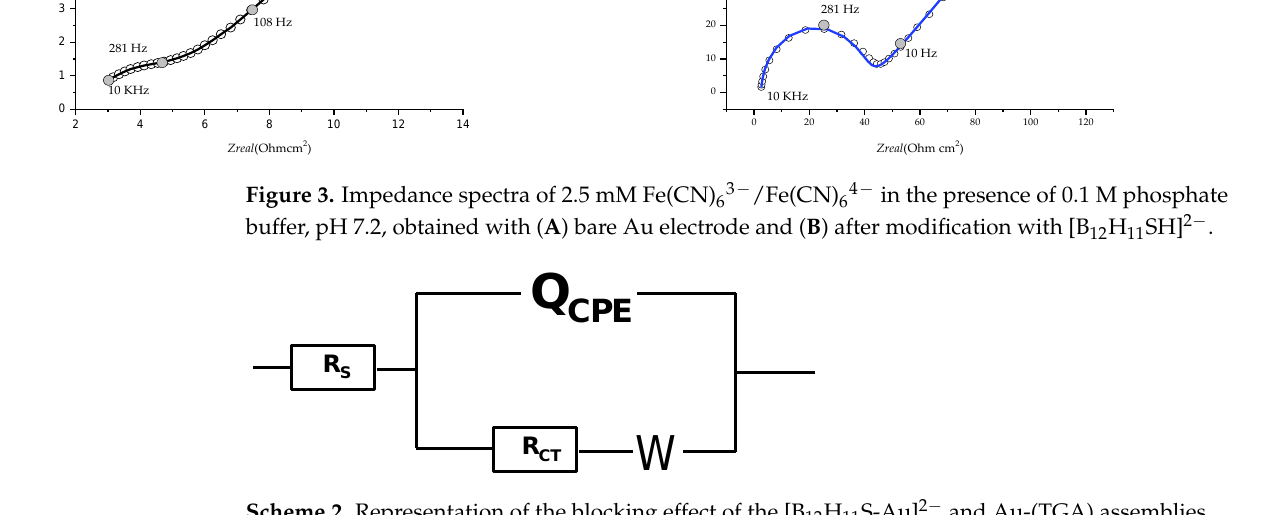
Scheme 2. Equivalent circuit used for fitting EIS spectra. Table 1. Parameters of the Randles circuit fitted to the impedance spectra.